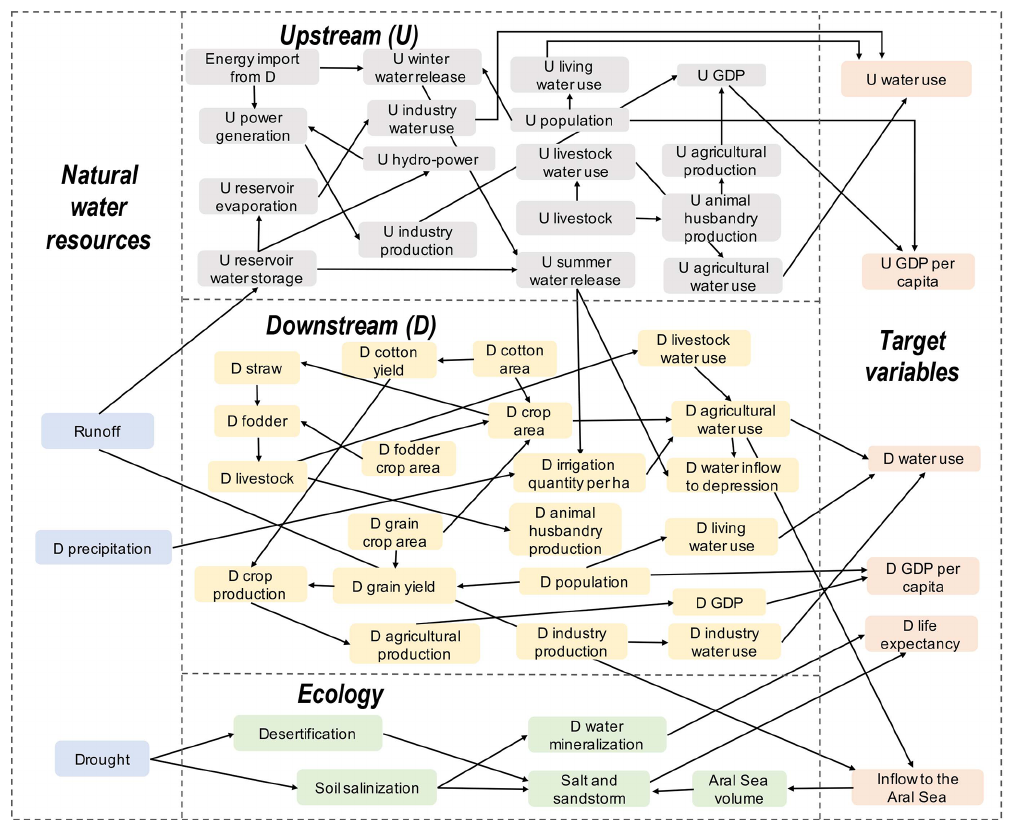
Figure 6. The Bayesian network structure shared by the ADB and SDB when simulating the water–energy–food–ecology nexus. D stands for “downstream” and U stands for